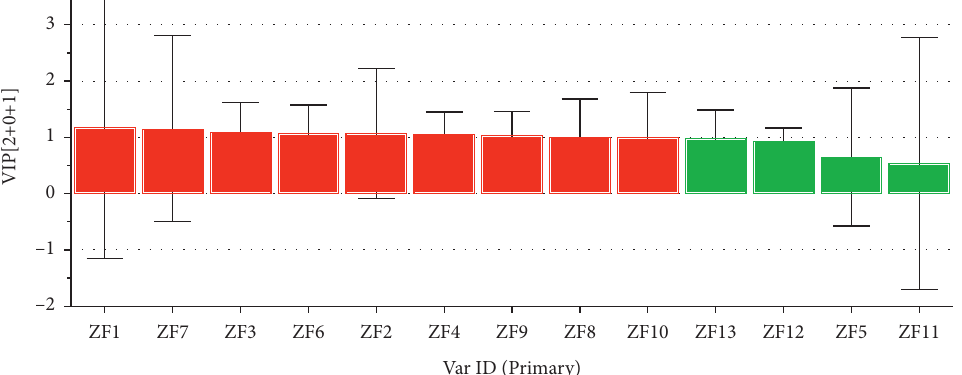
Figure 8: VIP values of 13 common